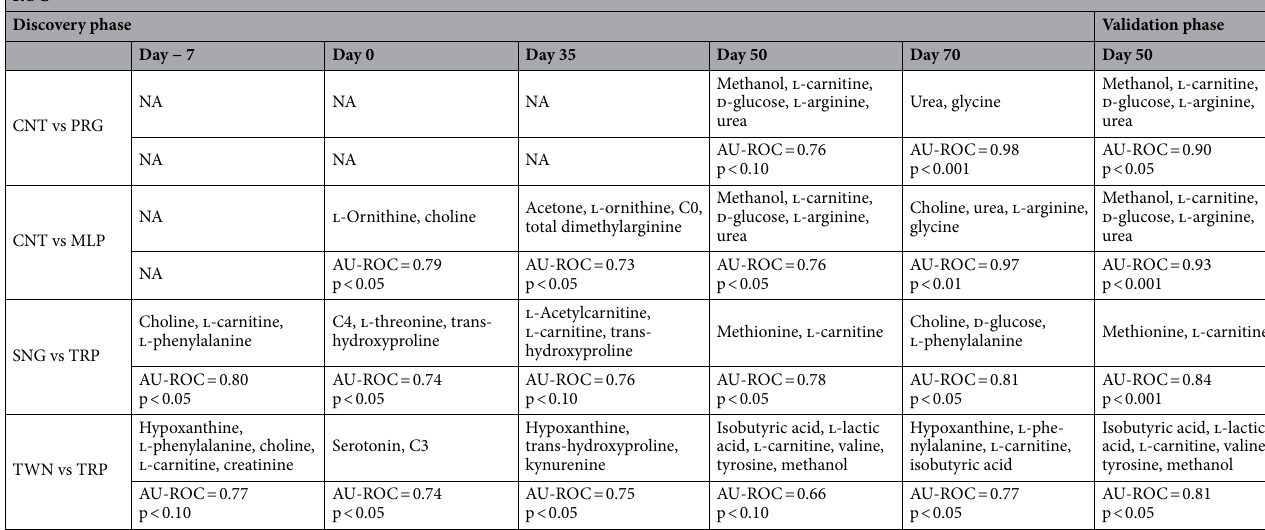
Table 5. Receiver operating characteristics (ROC) analysis of the comparison groups in the discovery and validation datasets. Candidate biomarkers were evaluated during all five timepoints of the discovery phase and day 50 of gestation was the best timepoint to reveal candidate biomarkers of ewe PLS. Therefore, biomarker analysis was pursued for only day 50 of gestation in the validation phase. The panel of metabolites that reached an area-under-the-curve (AU-ROC) of at least 0.65 or were significant (p-value < 0.05) were considered as candidate biomarkers in the discovery phase and were confirmed as biomarkers if the AU-ROC and p-value improved in the validation analysis. NS Not significant, NA biomarker not available, CNT control open ewes, PRG pregnant ewes, SNG pregnant ewes that delivered one lamb, TWN pregnant ewes that delivered two lambs, TRP pregnant ewes that delivered more than two lambs. Day − 7 refers to seven days prior to initiation of gestation and day 0 is the start of